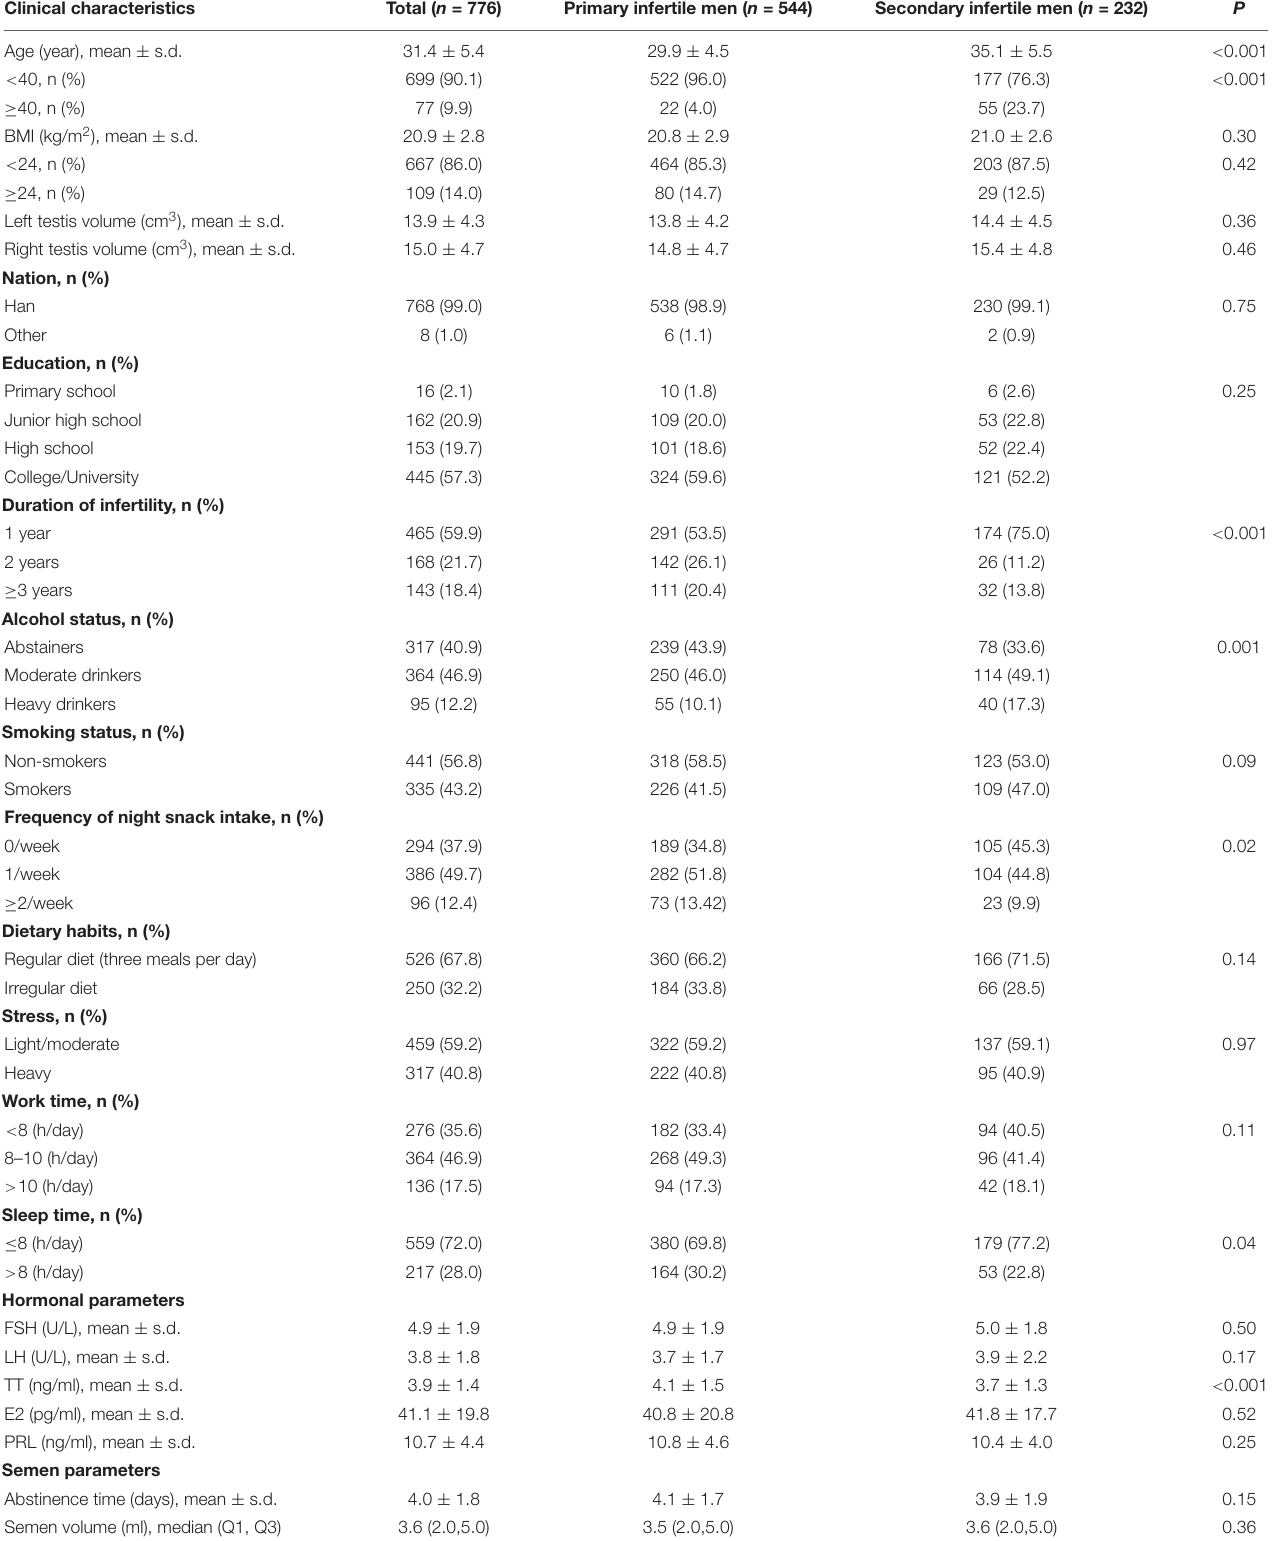
TABLE 1 | Characteristics and descriptive statistics of the whole cohort. Clinical